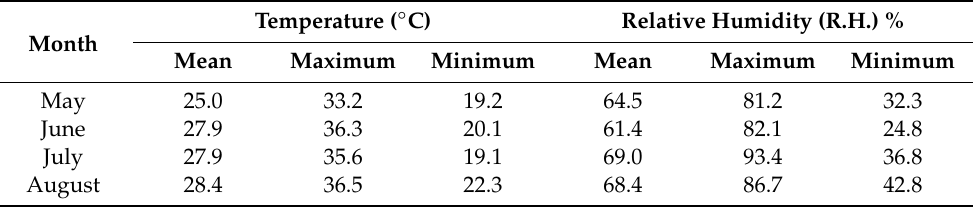
Table 4. Greenhouse temperature and relative humidity conditions during the experimental period. Temperature ( ◦